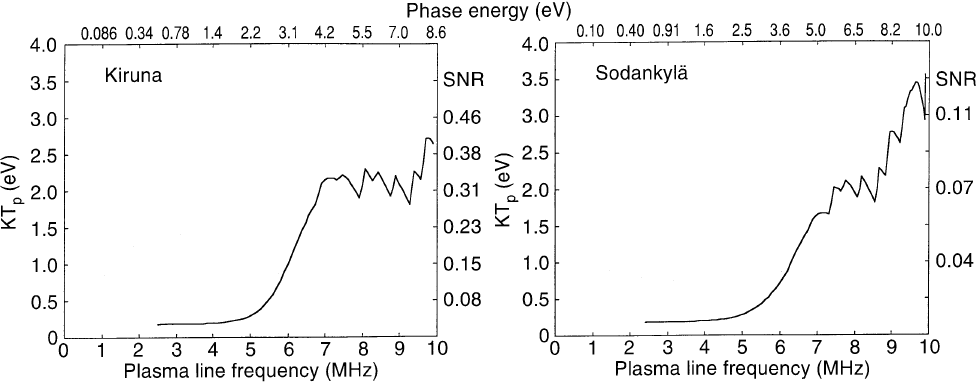
text for details). The lower x - axis gives the plasma line frequency, while the upper gives the phase energy for the resonant electrons (for comparisons with Fig.